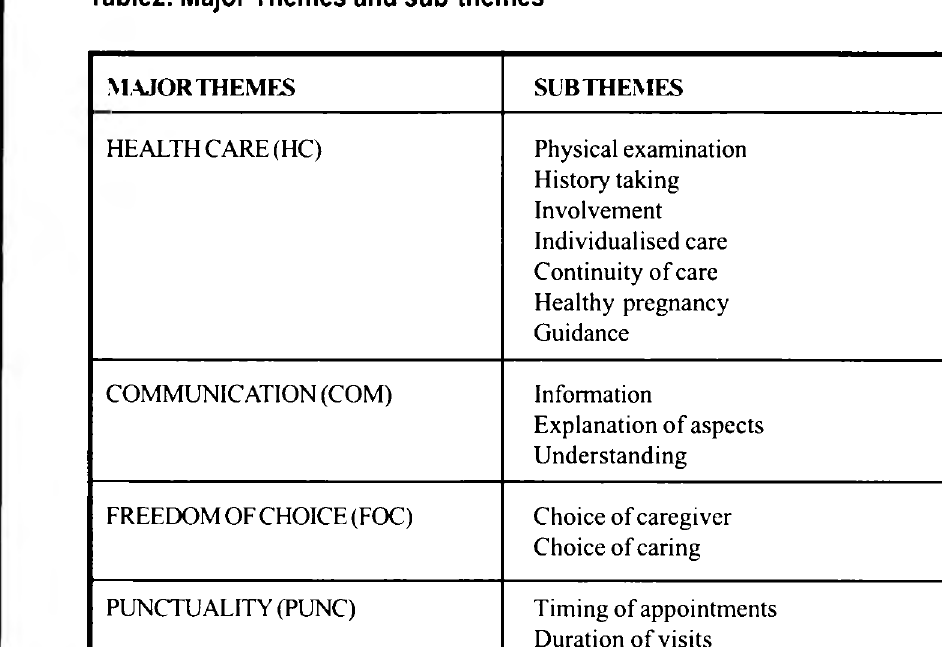
Table2. Major Themes and